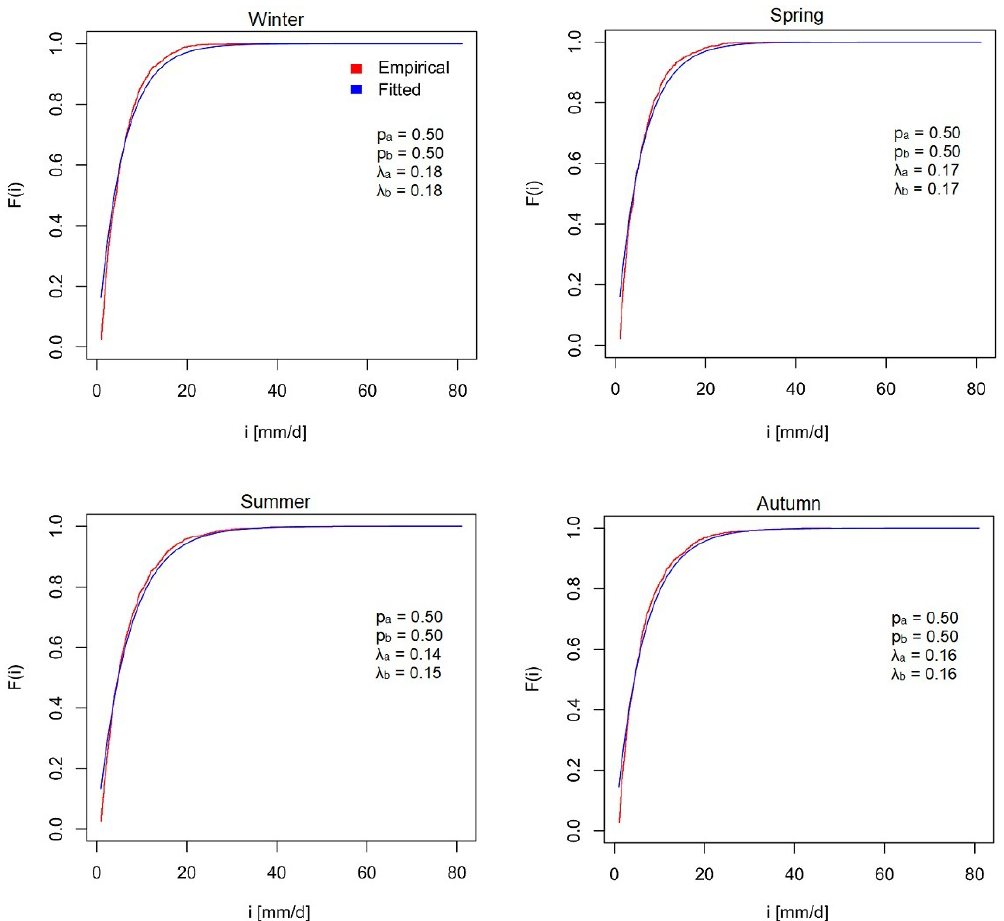
Figure 2. Fitted two-component mixed exponential distributions compared to empirical cumulative density functions of seasonal observed (Uccle) daily precipitation intensities. λ a , ie and λ b , ie are the rate parameters for populations a and b with different exponential distributions. p a is the weight of population a, and p b is the complement of the weight of population a (p b = [ 1 − p a ] )